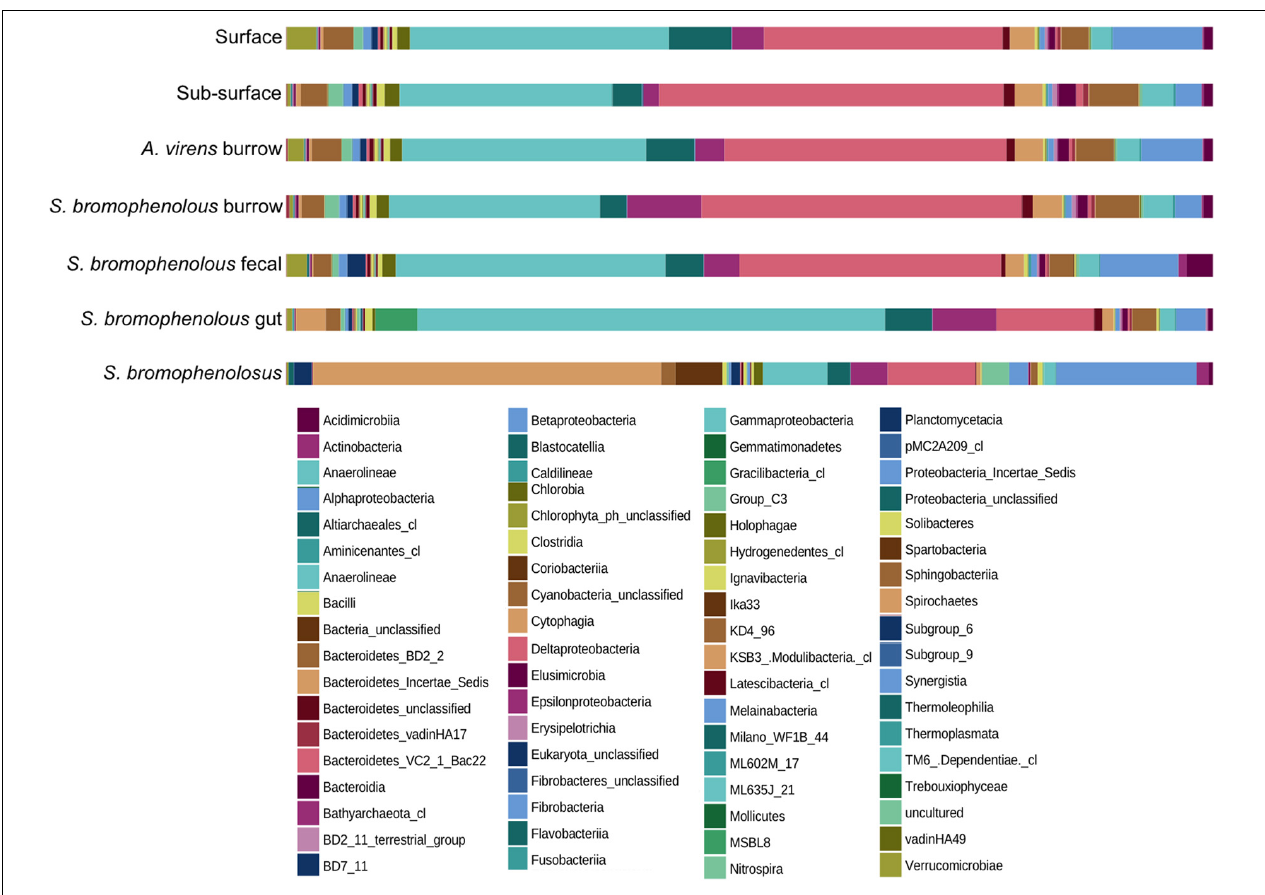
FIGURE 1 | Percent composition of animal and sediment microbial communities. Percent composition by class of microbial communities in surface and sub-surface sediments, burrows of Alitta virens , burrows of Saccoglossus bromophenolosus , S . bromophenolosus fecal castings, S . bromophenolosus gut sediments, and whole, sediment-free S . bromophenolosus . Delta- and Gammaproteobacteria dominate sediment samples, while Gammaproteobacteria and Spirochaetes dominate S . bromophenolosus gut sediments, and whole, sediment-free S . bromophenolosus ,